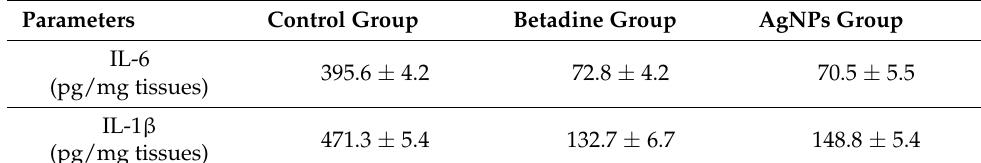
Table 3. The levels of IL-6 and IL-1 β of the wound tissues of the different groups.